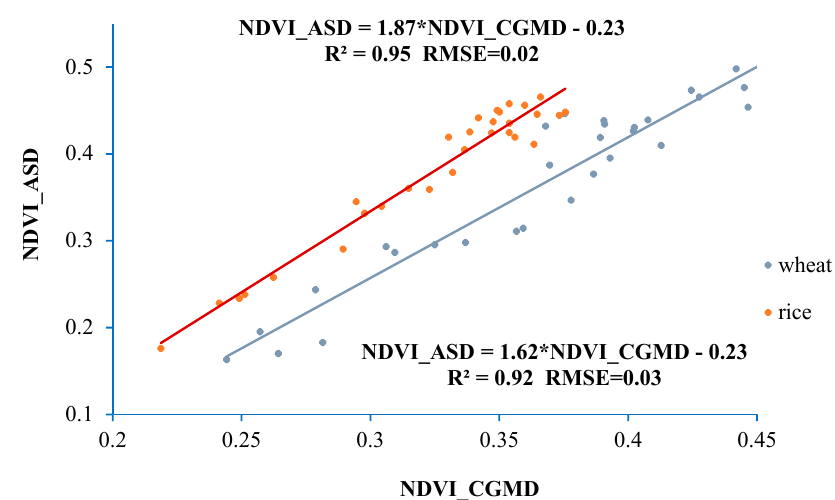
Figure 15. Fitting curve of NDVI measured using the CGMD apparatus and the ASD spectrometer.